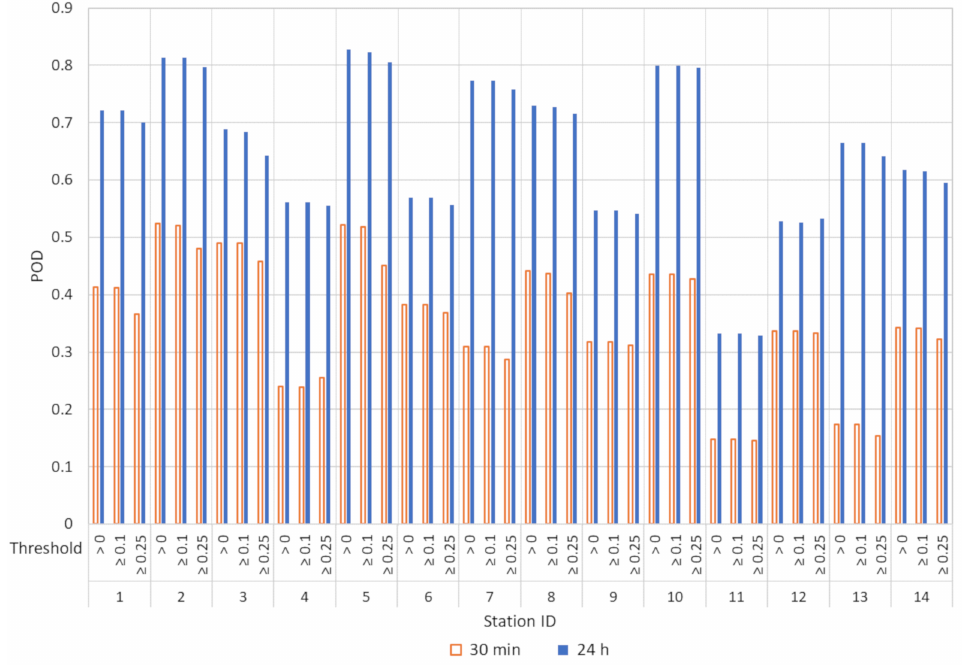
Figure 2. Probability of detection (POD) results by station for di ff erent analyzed thresholds.